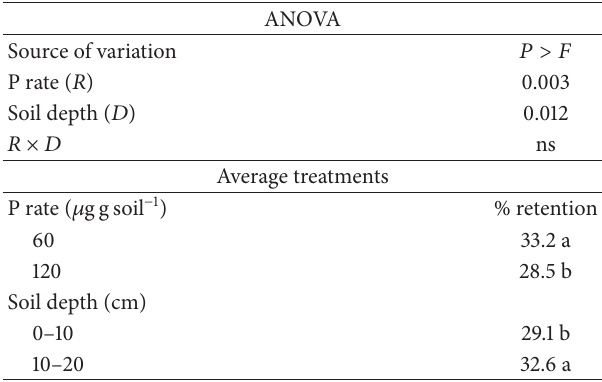
Table 5: Analysis of variance of P recovery (%) at Necochea affected by P rate and soil